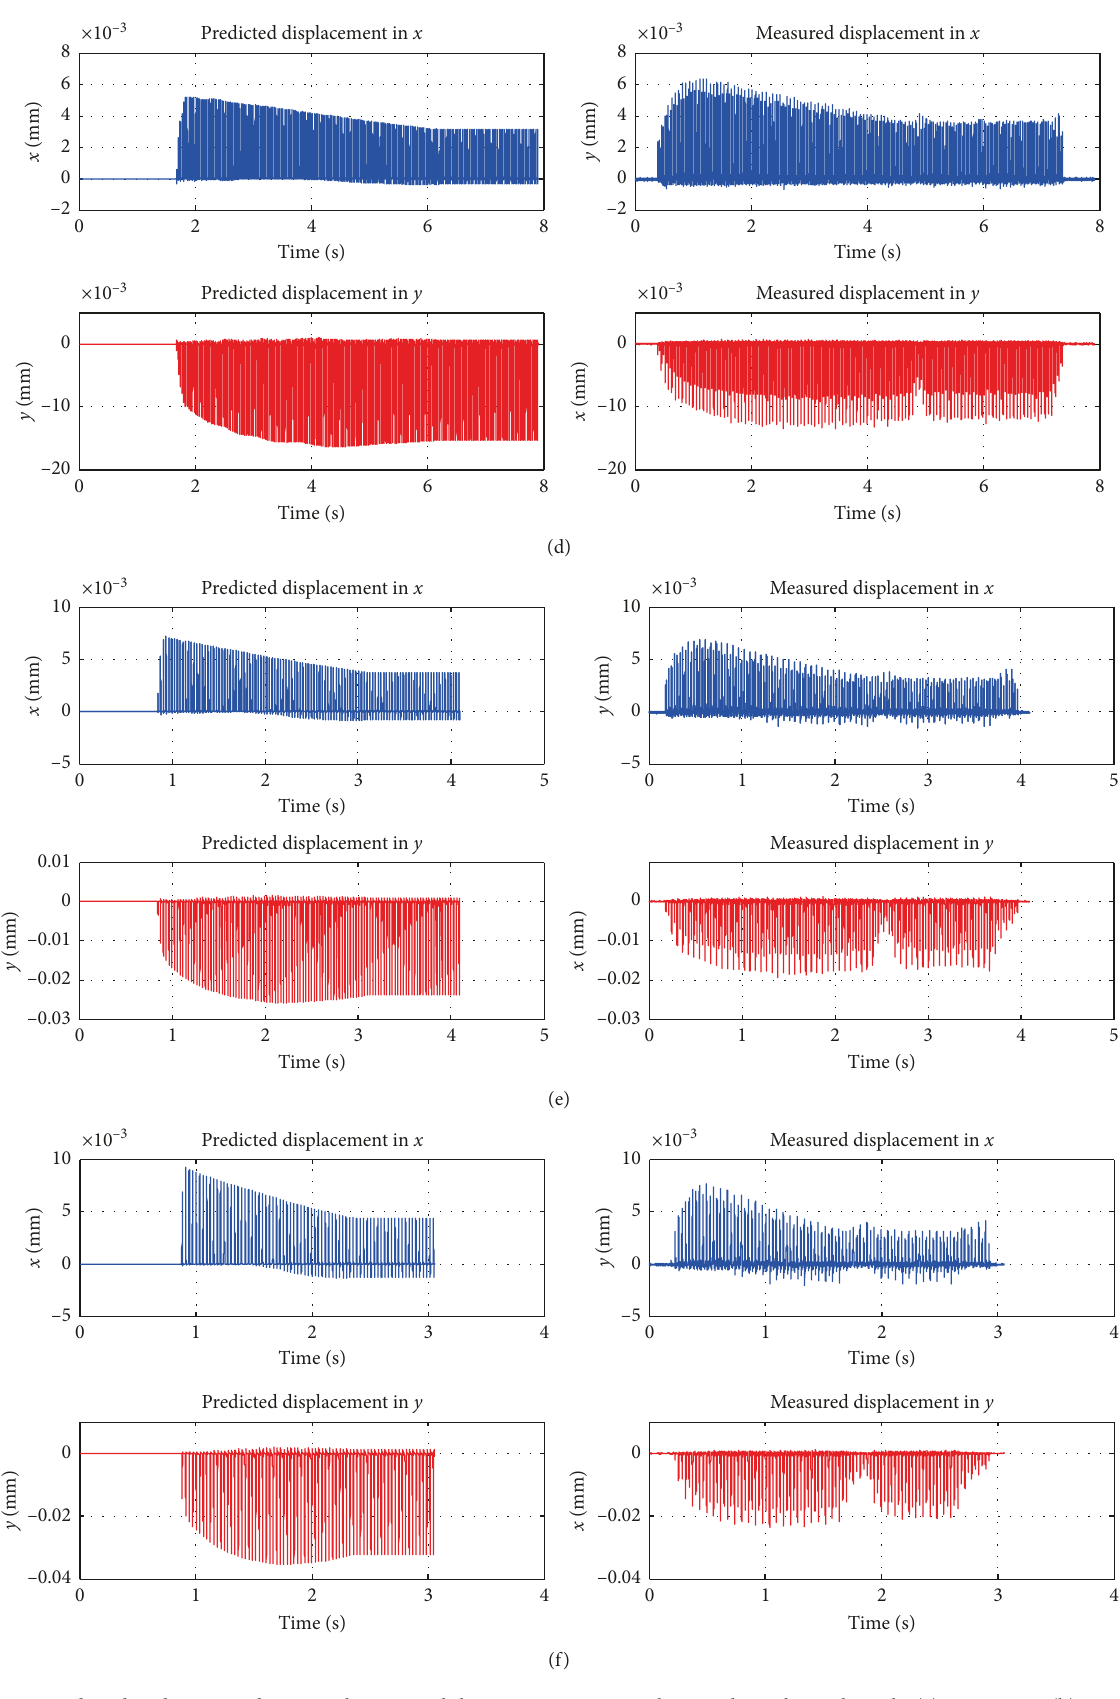
Figure 18: Predicted and measured cutter vibrations while cutter entering workpiece along the cycle path: (a) Test No. 1, (b) Test No. 2, (c) Test No. 3, (d) Test No. 4, (e) Test No. 5, and (f) Test No.